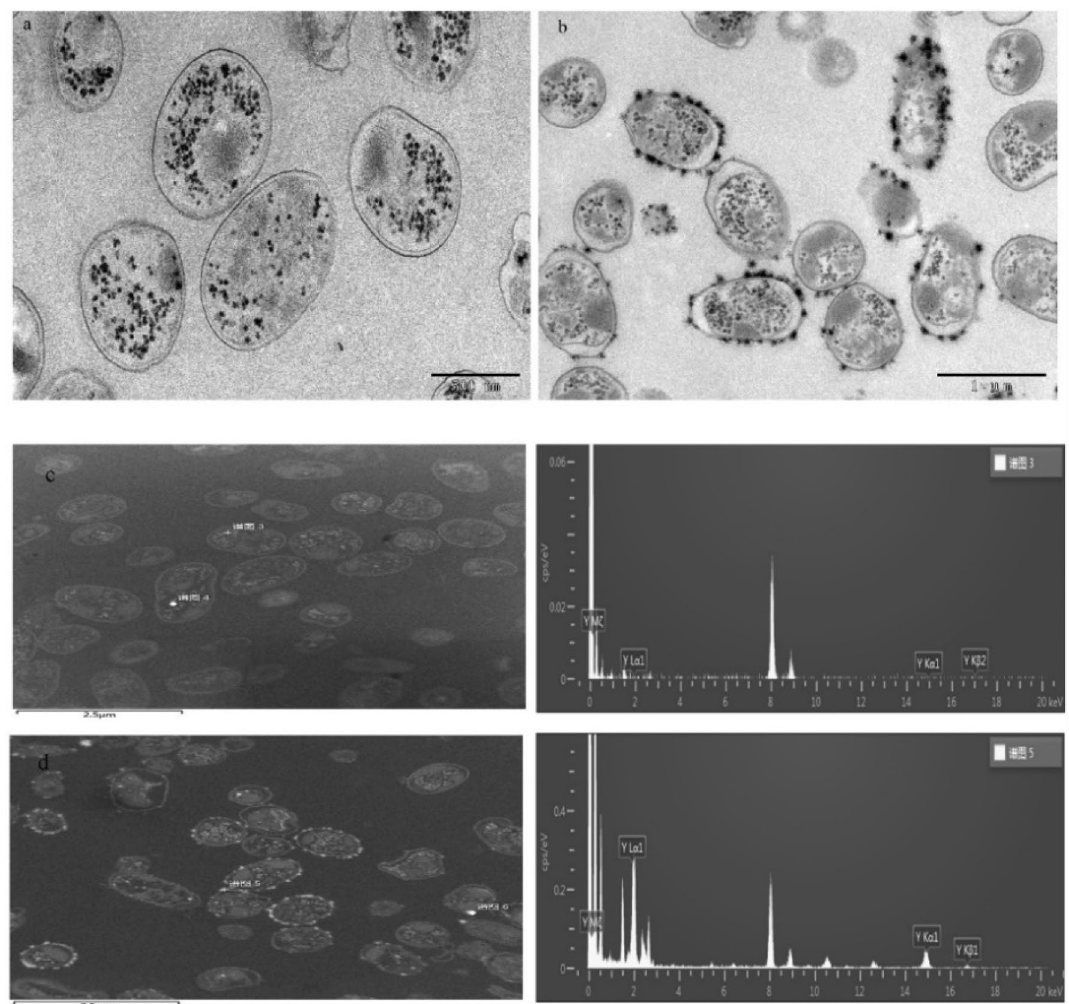
Figure 4. FITEM micrographs of S. marcescens before ( a ) and after biosorption Y(III) ( b ), EDS analysis of S. marcescens before ( c ) and after biosorption Y(III) ( d